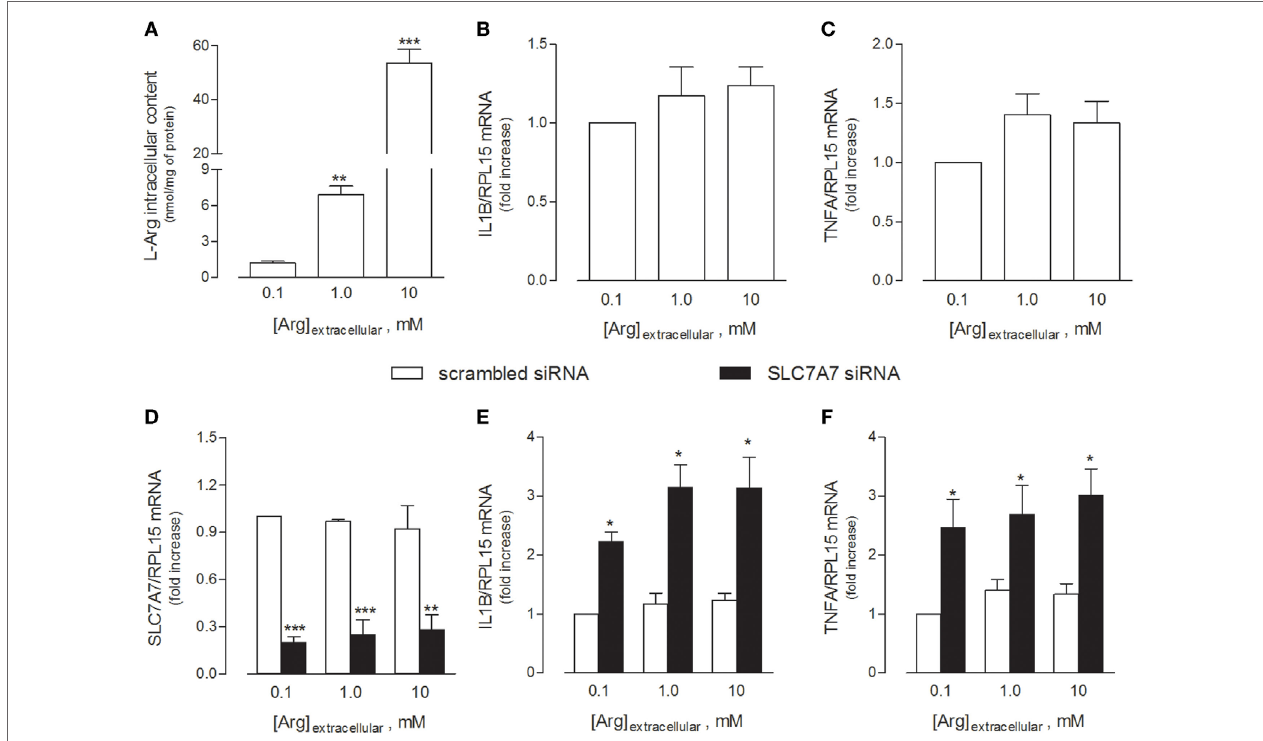
FigUre 2 | THP-1 cells were grown in the presence of the indicated concentrations of extracellular arginine. (a–c) Cells were differentiated to macrophages by exposure to 80 nM phorbol-12-myristate-13-acetate (PMA) for 96 h, then arginine content was measured by means of HPLC/ESI-MS-MS (a) , while the expression of IL1 β (B) and TNF α (c) mRNAs was monitored with RT-qpolymerase chain reaction (RT-qPCR). Data are mean ± SEM of five independent determinations. *** p < 0.001 vs . [Arg] extracellular 0.1 mM. (D–F) Cells were transfected with scrambled or SLC7A7 short interference RNA (siRNA) along the PMA-induced differentiation, as described in Section “Materials and Methods,” and analyzed for the expression of SLC7A7 (D) , IL1 β (e), and TNF α (F) mRNAs with RT-qPCR. Data are mean ± SEM of four different determinations, each performed in duplicate. * p < 0.05, ** p < 0.01, *** p < 0.001 vs . scrambled siRNA with one-way ANOVA followed by Bonferroni post hoc